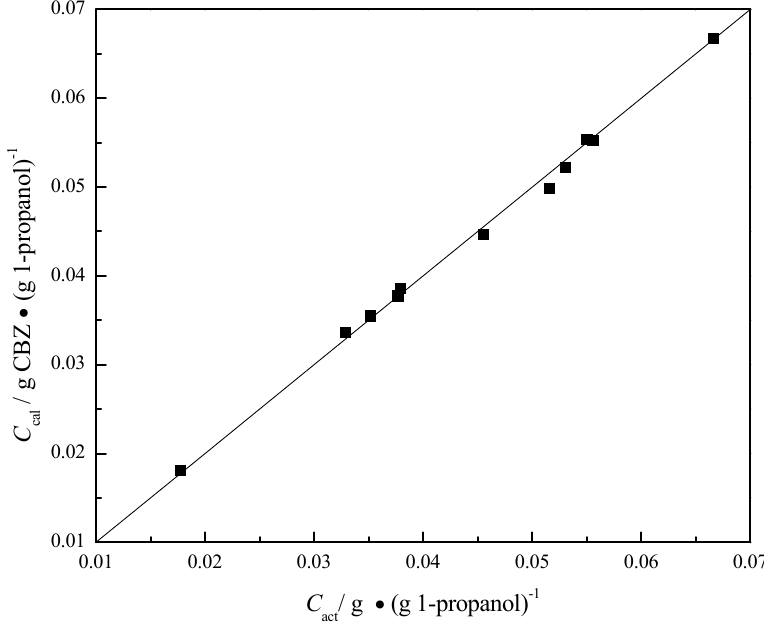
Figure 4. Comparison between actual and calculated concentrations.